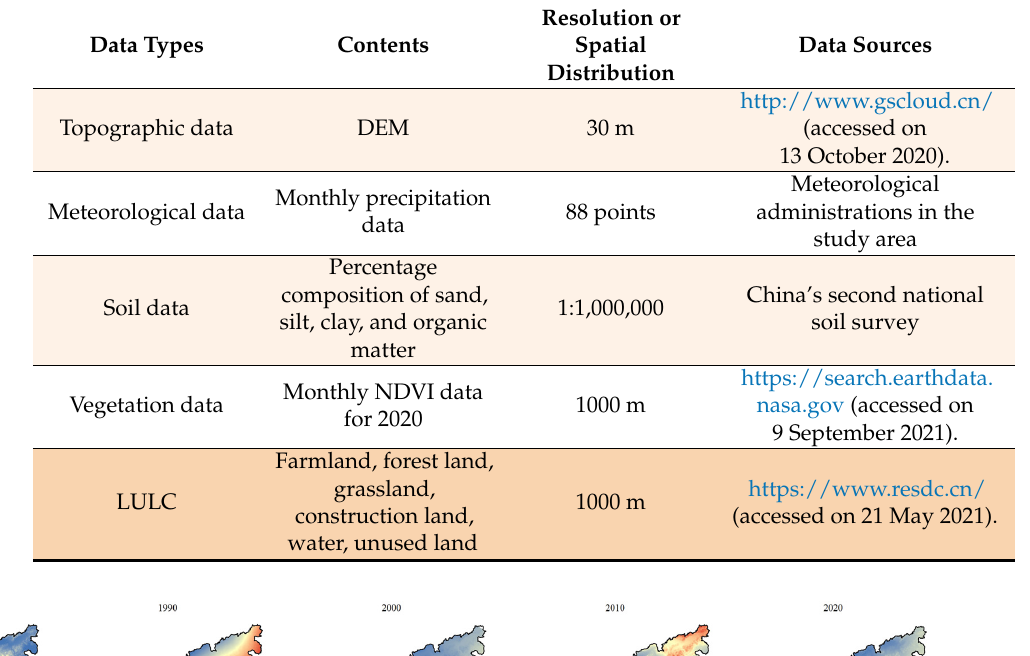
Table 1. Datasets and resources used in this study.